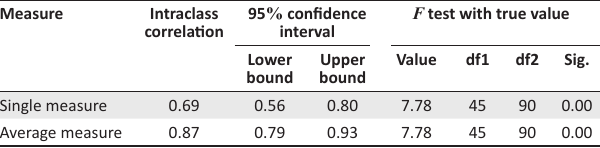
FIGURE 7: Bland–Altman plot showing the difference between the amplitude of accommodation at 40 cm and 33 cm. TABLE 4: Intraclass correlation coefficients in the measured amplitude of accommodation using the minus lens method with targets at 6 m, 40 cm or 33 cm, where n =